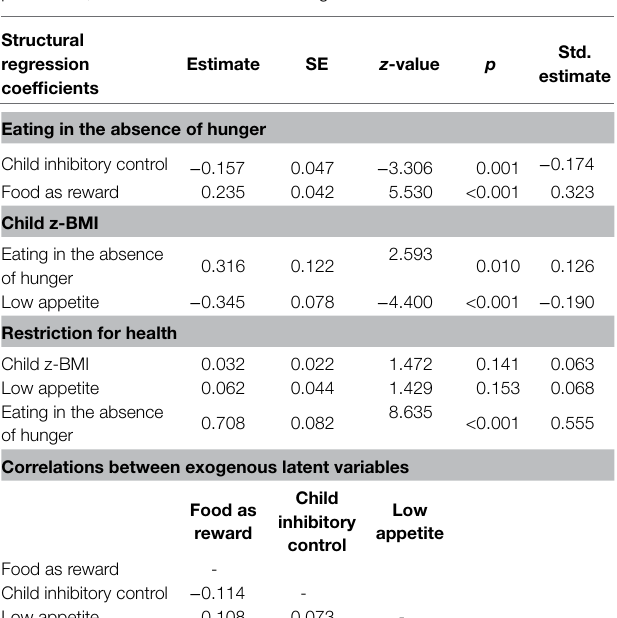
TABLE 7 | SEM model 2B: parameter estimates, SE, z -values, value of p , and standardized estimates (i.e., completely standardized solutions) for regression parameters, and correlations between exogenous latent